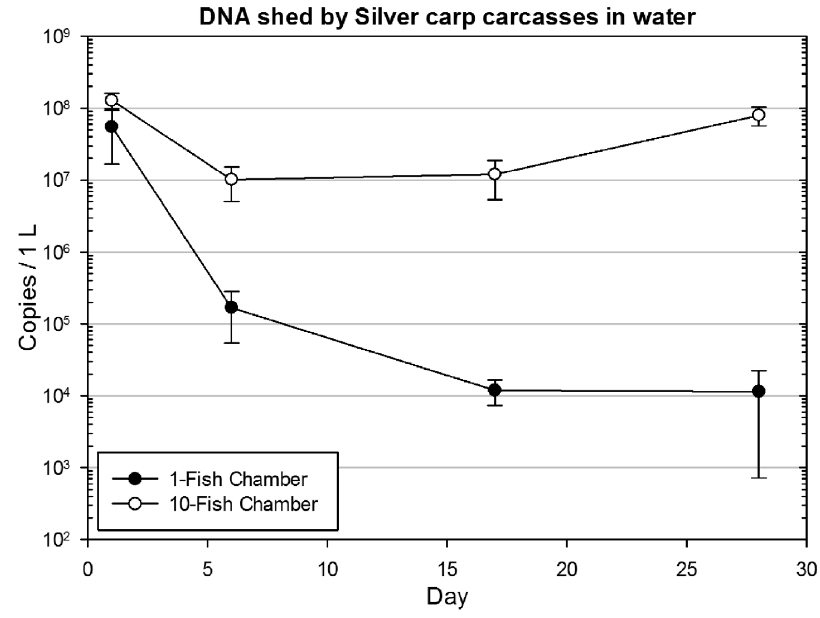
Figure 2. Copies of DNA shed by silver carp carcasses per liter of flowing water. Plots with open circles represent chambers containing 10 juvenile silver carp and plots with dark circles represent chambers containing a single juvenile silver carp. Each point represents the mean of 12 replicate samples (4 replicate chambers, 3 water samples each), and error bars are 6 SEM. Copy numbers of the water samples from single-carcass chambers were compared to those from 10-carcass chambers Welch’s t-test. On day 28, the water samples from 10-carcass chambers contained significantly more copies of DNA than those from single-carcass chambers (p , 0.05).